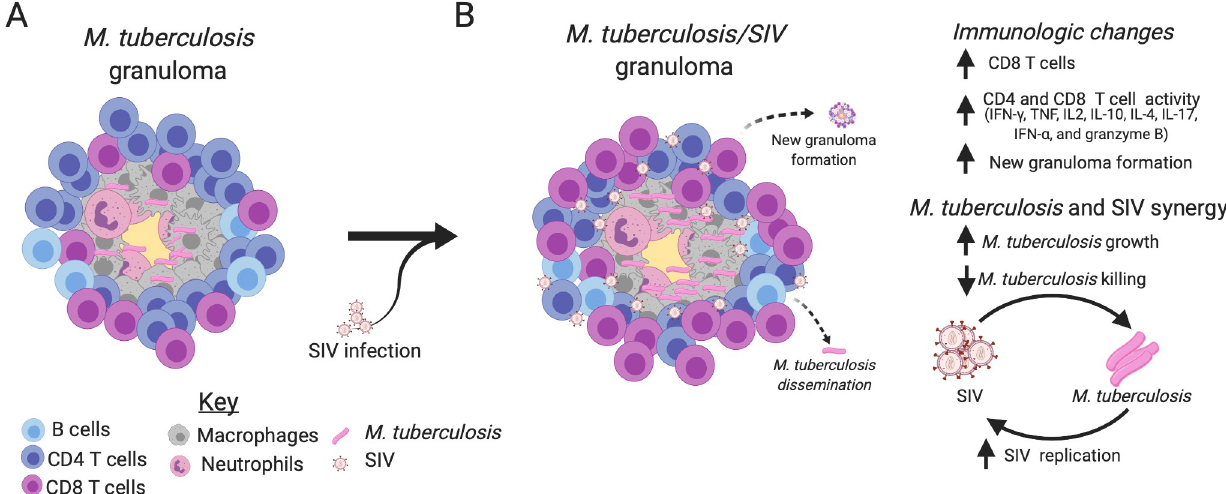
Fig 7. SIV changes immunological functions within Mtb lung granulomas, increases Mtb growth, and reduces Mtb killing. A) An example Mtb caseous granuloma contains T cells, B cells, macrophages, neutrophils, and Mtb. B) Mtb/SIV co-infected granulomas contain more CD8 T cells and an increase in overall production of Th1 cytokines, granzyme B, IL-17, IL-10, IL-4, and IFN- α by CD4 and CD8 T cells. SIV also increases the probability of causing new granulomas to form, Mtb growth and dissemination. SIV has been linked to increases in Mtb growth and a reduction in Mtb killing during reactivated disease, while Mtb growth correlates to increases in SIV replication. This suggests that lung granulomas are sites that support a synergistic relationship between SIV replication and Mtb growth. Image created by